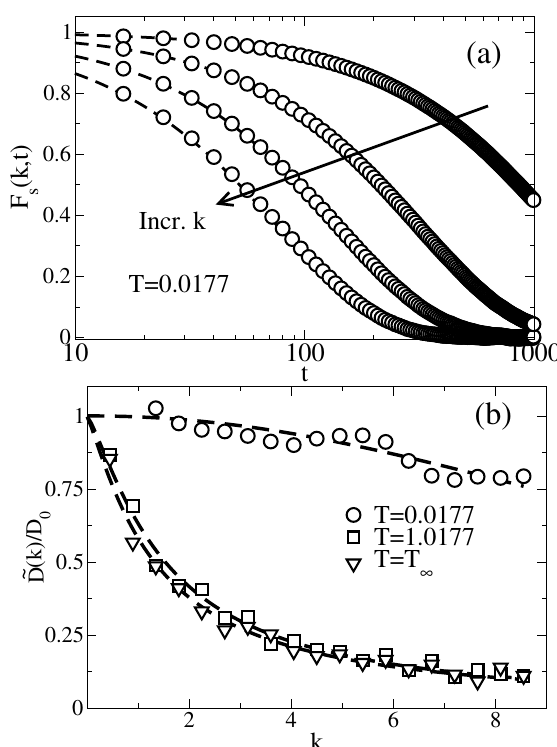
Figure 1: Molten salt (a): Incoherent intermediate scattering function for different wavevec- tors (circles). Punctured line is f ( k , t ) = e − displacement. (b) The diffusion kernel at different temperatures. Punctured lines